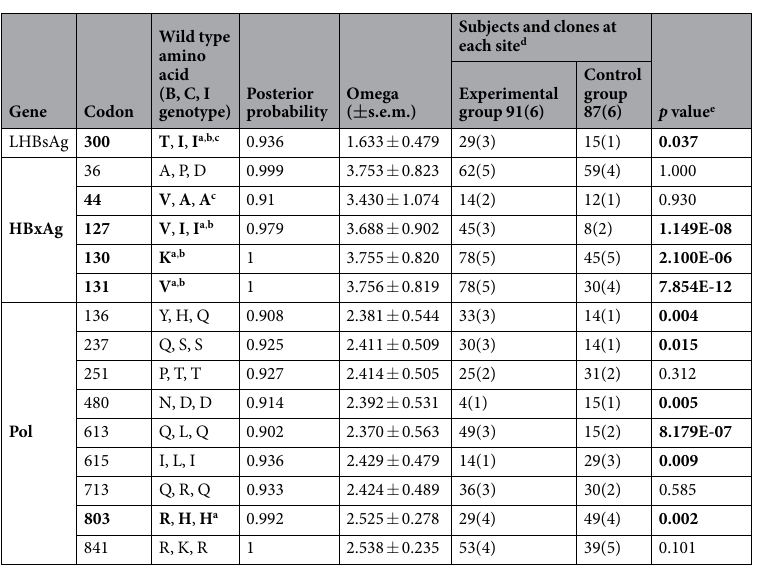
Table 4. Codons in the HBV genes that were under positive selection. a HLA I T cell epitopes, b HLA II T cell epitopes, c B cell epitopes. d The number of clones with positive selection (the number of affected patients). e The number of clones with positive selection in HBsAg + /anti-HBs + group vs HBsAg + /anti-HBs- group, chi- square